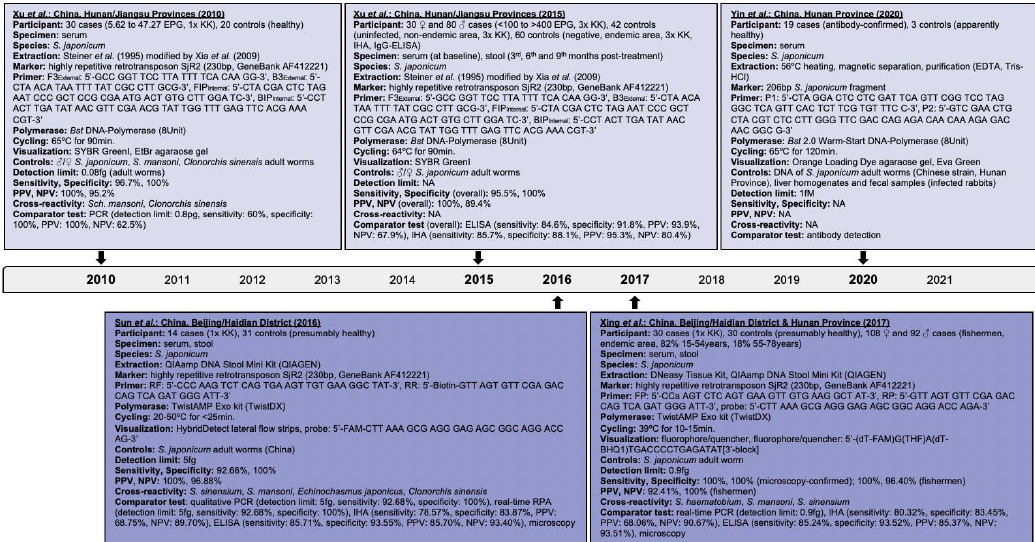
Figure 2. Articles identified on the isothermal diagnosis of Schistosoma japonicum with details on participants, specimens, assay features, and test evaluation in terms of detection limits, sensitivity, specificity, PPV and NPV versus a comparator test by chronological order of publication date. Articles highlighted in light blue delineate schistosomal diagnosis based on loop-mediated isothermal amplification (LAMP) while articles highlighted in blue delineate schistosomal diagnosis based on recombinase polymerase amplification (RPA). We searched databases of PubMed, Embase and Web of Science for suitable publications on the isothermal diagnosis of schistosomiasis among clinical specimens collected from human subjects by applying the following terms: “schistosomiasis”, “Schistosoma”, “snail fever”, “schistosomiasis MeSH Terms”, ”isothermal”, “diagnosis/diagnostic”, “detection”, and “assay”. The last searches were performed on 31 December 2021. Publications included after removing duplicates, screening titles and abstracts, reading full-texts, and complementing through reference searches were not restricted by time period, but by the availability of full-texts available in English. Experimental animal studies, investigations on intermediate mollusk hosts, reviews and math- ematical models were excluded unless considered highly relevant. Abbreviations: S. = Schistosoma , EPG = eggs per gram, KK = Kato-Katz, bp = basepair, min = minutes, EtBr = ethidium bromide, = male, = female, PCR = polymerase chain reaction, PPV = positive predictive value, ♀ ♂ NPV = negative predicitive value, ELISA = enzyme-linked immunosorbent assay, IHA = indirect haemagglutination assay, fg = femtogram, fM = femtomolar, pg = picogram, Bst = Bacillus stearother- mophilus , NA = not available, EDTA = ethylenediaminetetraacetic acid, HCl = hydrogen